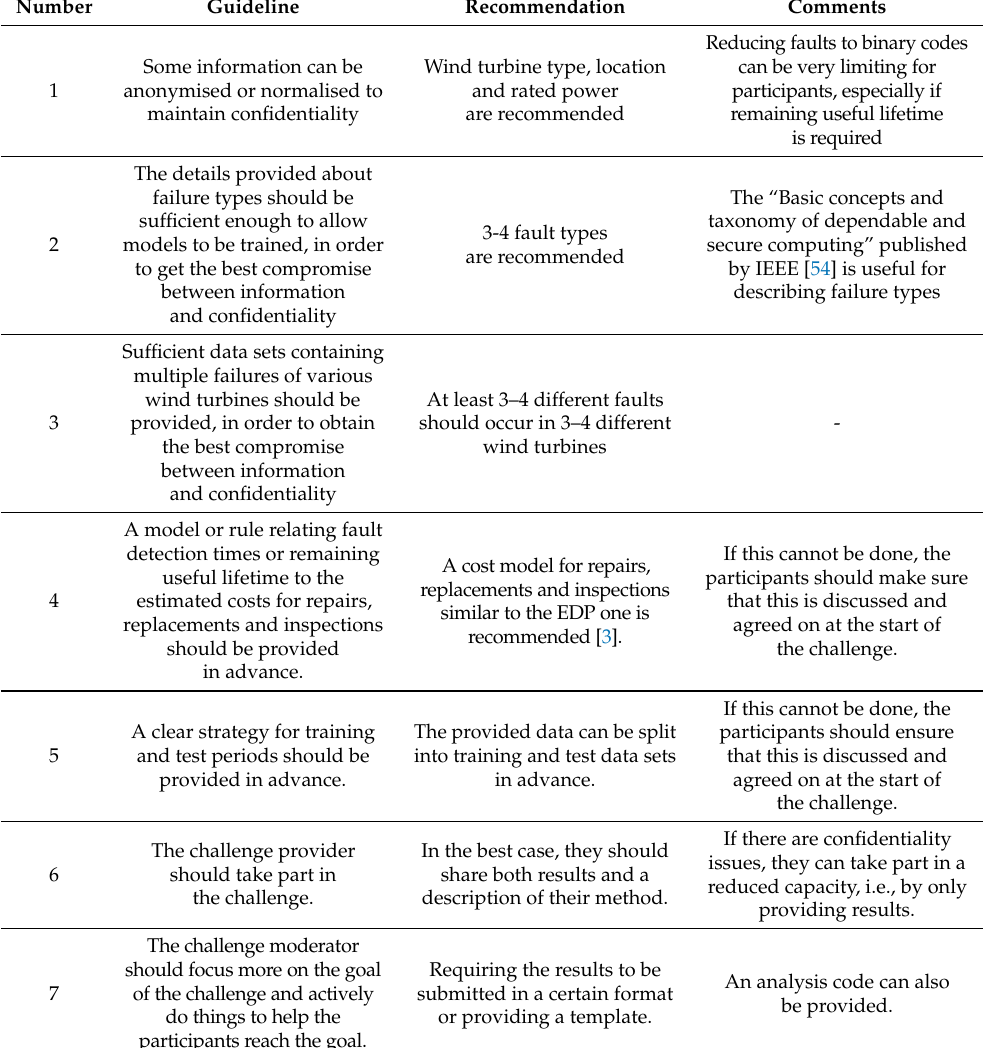
Table 5. Best practice data sharing guidelines for wind turbine fault detection model